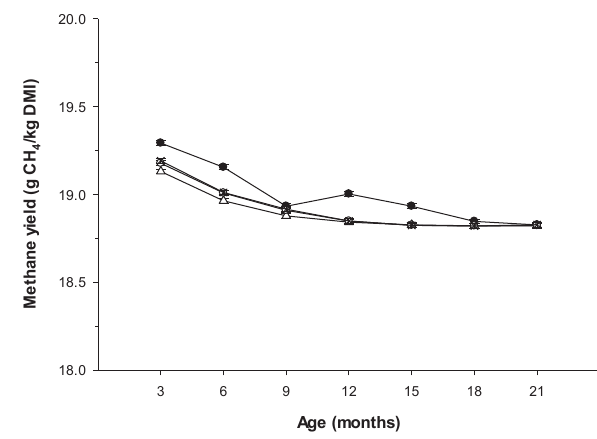
Figure 2. Comparative estimations of methane yield emissions between Local Yellow ( Bos indicus )×Red Sindhi ( Bos indicus ; ●), and crossbred 1/2 Limousin (LS; ∆), 1/2 Drought Master (DS; ○) and Red Angus (RS; ×) cattle in household farming systems in Dak Lak province of Vietnam. Values are least squares means±standard error of the mean.